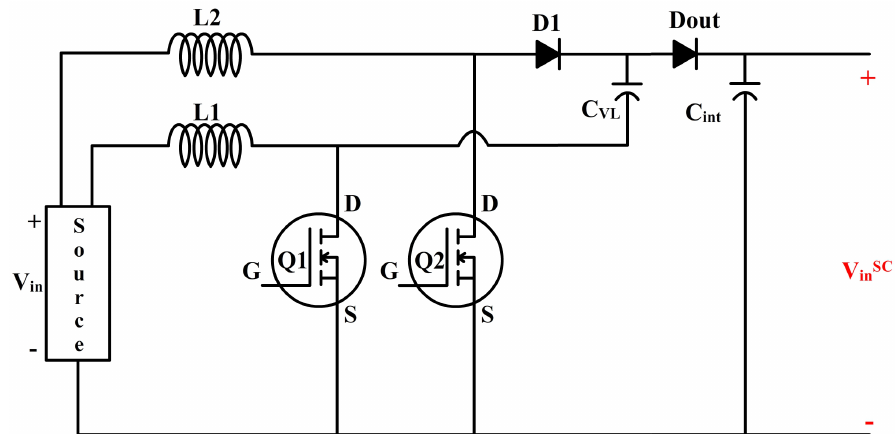
Figure 3. Interleaved stage of the proposed